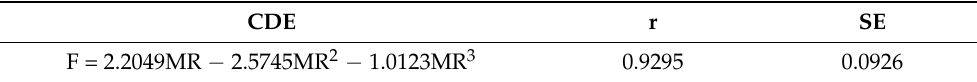
Table 3. The polynomial equation of the characteristic drying equations (CDE). CDE